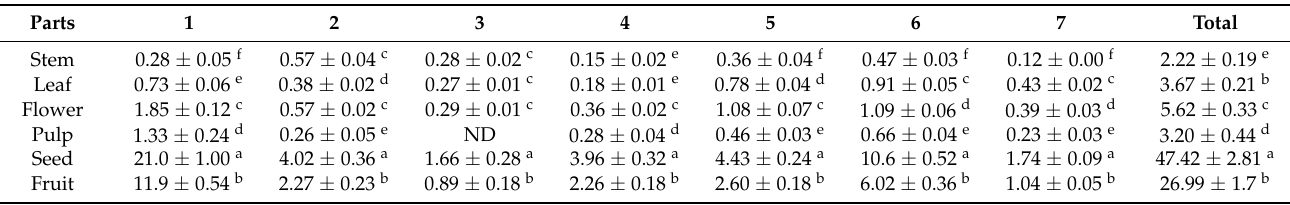
Figure 2. HPLC chromatograms of standard lignans ( A ) and sevens lignans in various parts of S. chinensis ( B ) measured at 254 nm. Table 2. Contents of seven lignans in plant parts of S .